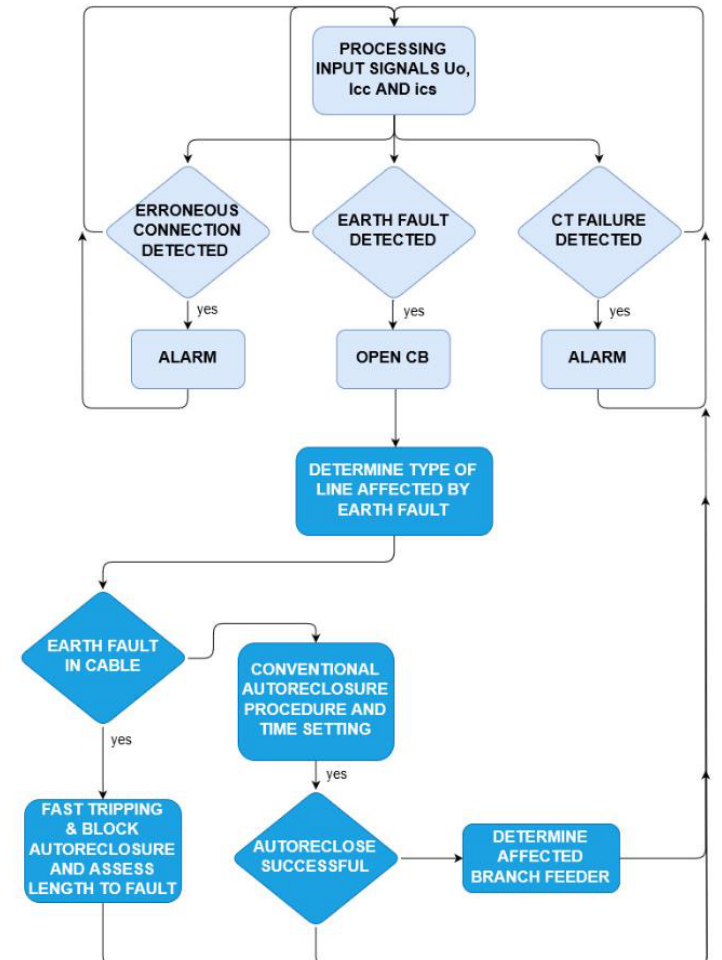
Figure 1. Schematic diagram of the developed system (the elements described in this study are marked in blue, and the elements in blue [5].